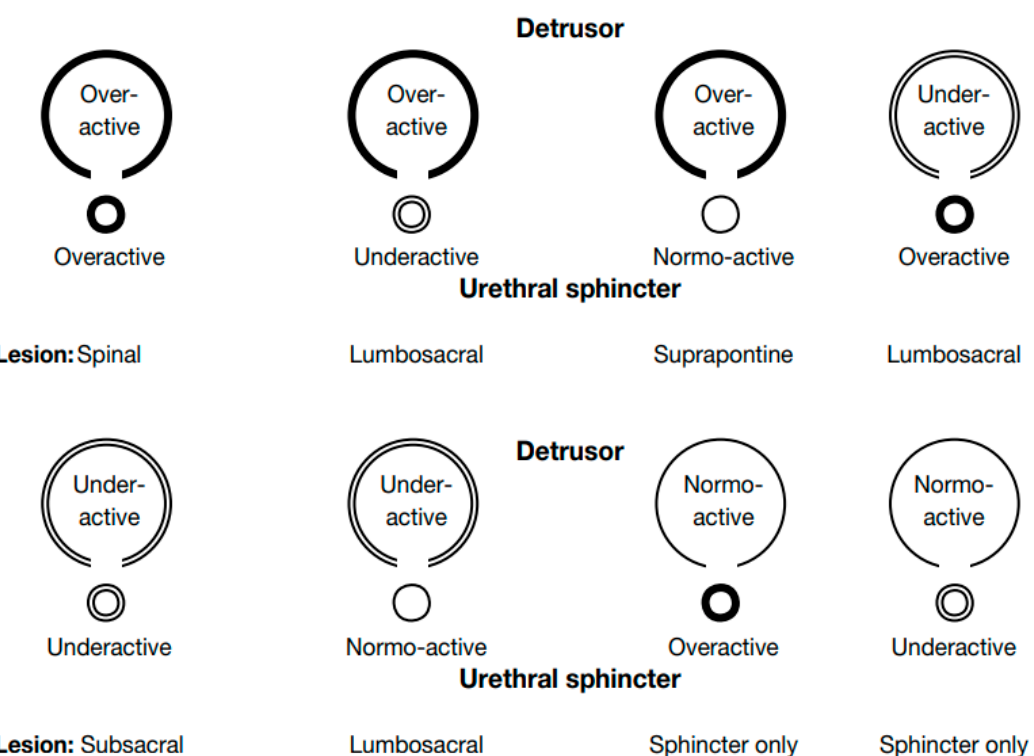
Figure 1. Madersbacher classification system showing typical neurological lesions.